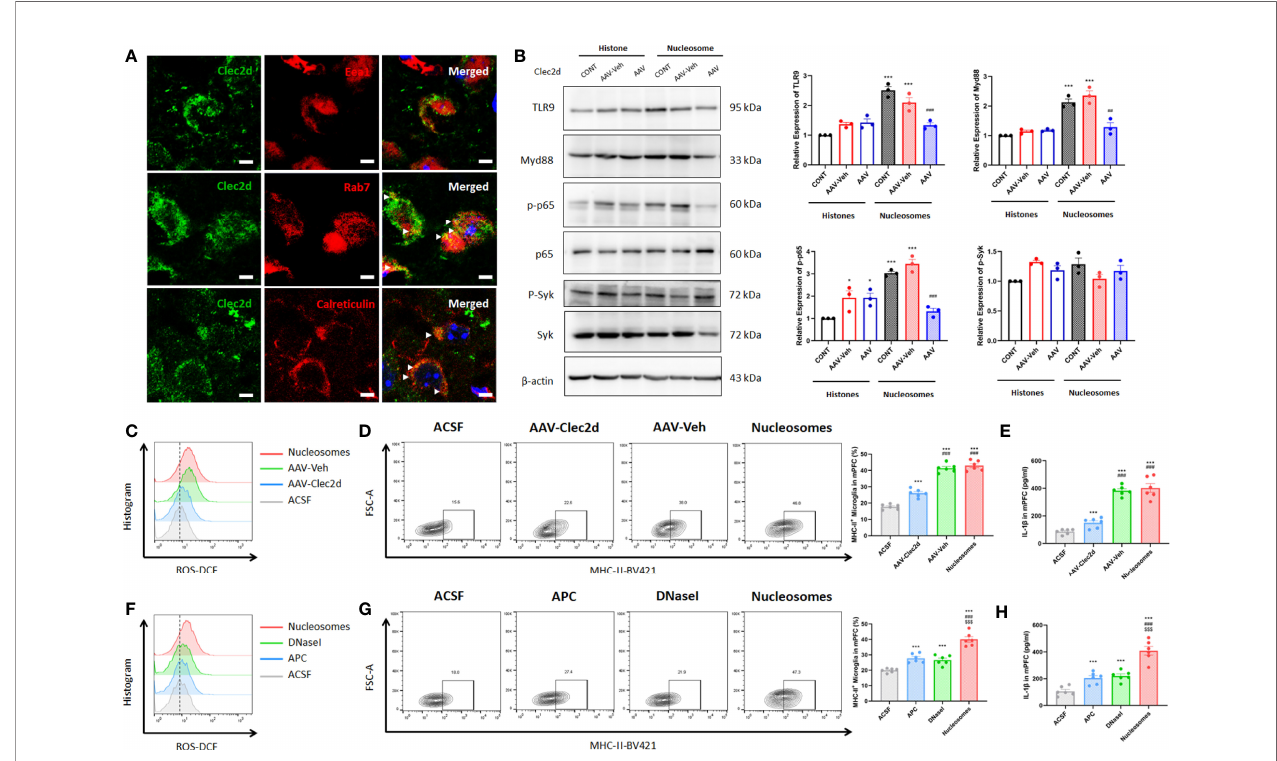
FIGURE 7 | Extracellular nucleosomes accelerated microglial in fl ammation via Clec2d and TLR9. (A) Representative immuno fl uorescence images showing the subcellular location of Clec2d and Eea1, Rab7, and calreticulin, as well as their relationship in primary microglia were presented. Scale bar: 150×. (B) Representative Western blots showing the expression of microglial TLR9, Myd88, p-p65, and p-Syk on 3 days after ACSF, histones, or nucleosomes stereotactic injection in mPFC with Clec2d knocking-down were presented. Relative expression of TLR9, Myd88, p-p65, and p-Syk on 3 days after ACSF, histones, or nucleosomes stereotactic injection in mPFC with Clec2d knocking-down was analyzed (two-way ANOVA with Tukey ’ s post hoc test post hoc , * P < 0.05, *** P < 0.001, compared with histones; ## P < 0.01, ### P < 0.001, compared with Nucleosomes-AAV-Veh; n = 3). (C) Representative fl ow cytometry images showing CD11b + CD45 Low microglial ROS on 3 days after ACSF or nucleosomes stereotactic injection in mPFC with Clec2d knocking-down were presented. (D) Representative fl ow cytometry images and statistical analysis showing the percentage of CD11b + CD45 Low MHC-II + microglia on 3 days after ACSF or nucleosomes stereotactic injection in mPFC with Clec2d knocking-down were presented (two-way ANOVA with Tukey ’ s post hoc test post hoc , *** P < 0.001, compared with ACSF; ### P < 0.001, compared with AAV-Clec2d; n = 6). (E) Concentration of IL-1 b on 3 days after ACSF or nucleosomes stereotactic injection in mPFC with Clec2d knocking-down was analyzed (two- way ANOVA with Tukey ’ s post hoc test post hoc , *** P < 0.001, compared with ACSF; ### P < 0.001, compared with AAV-Clec2d; n = 6). (F) Representative fl ow cytometry images showing CD11b + CD45 Low microglial ROS on 3 days after ACSF, APC pretreatment, DNase I pretreatment, or nucleosomes stereotactic